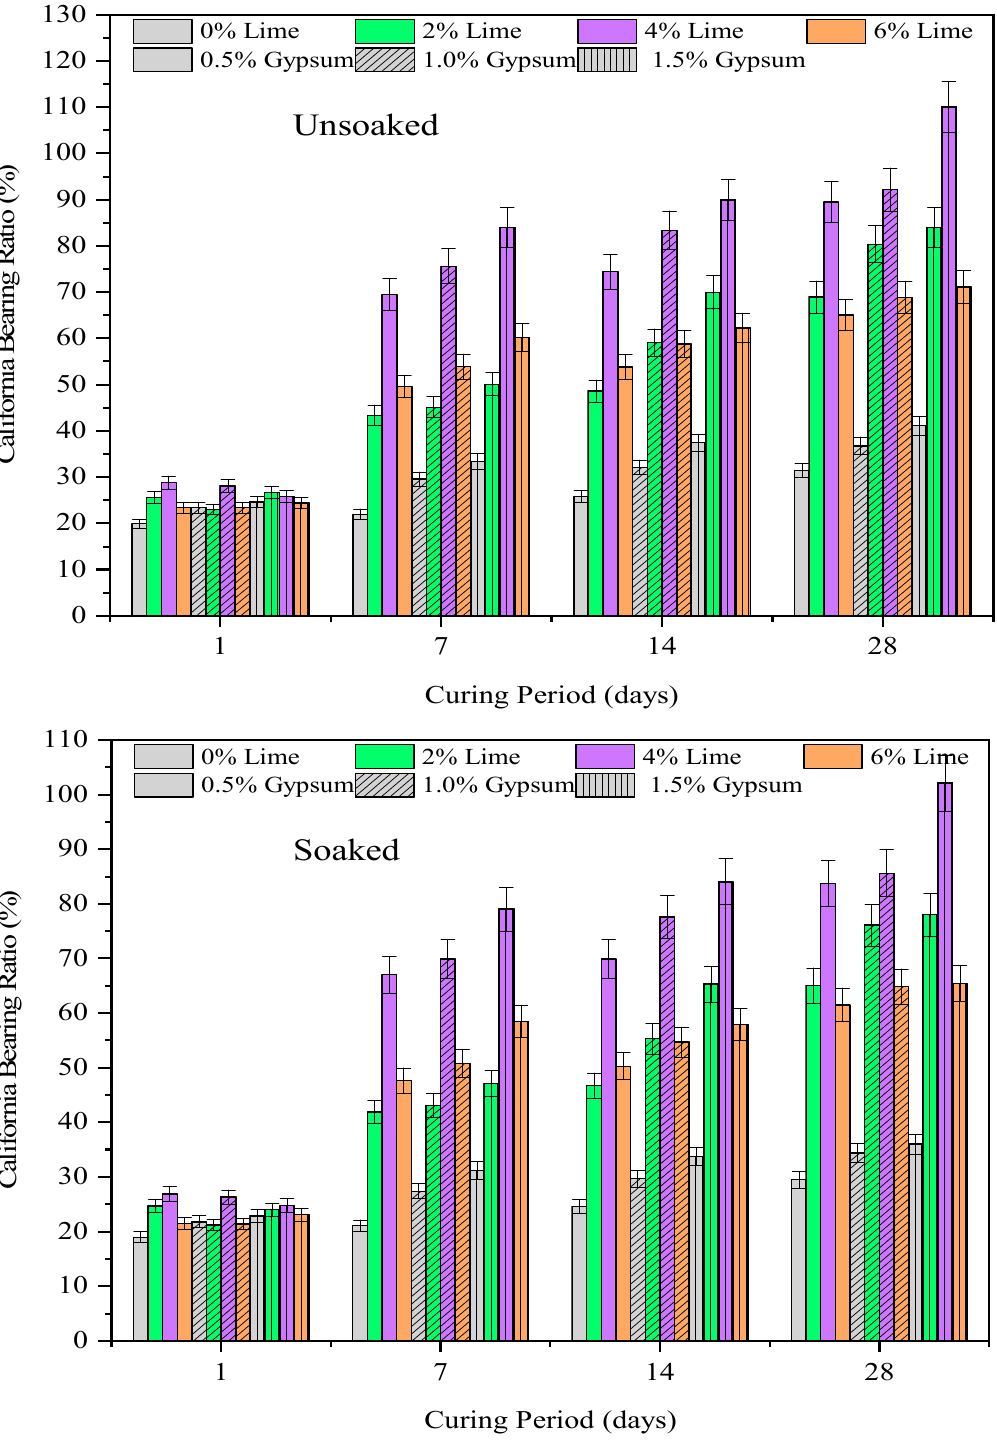
Figure 6. The variation in California bearing ratio (unsoaked and soaked) of lime treated coal gangue with gypsum and curing period up to 28 days.